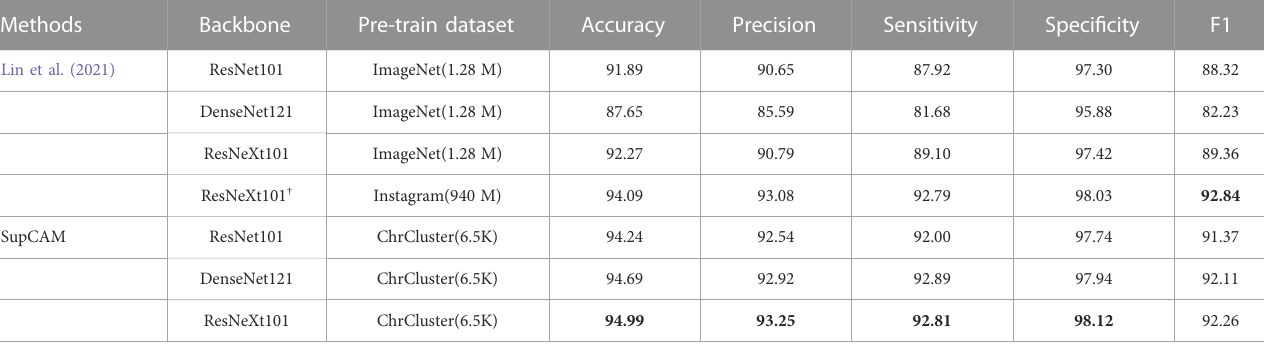
TABLE 1 Comparison with previous methods. All experiments were conducted following the division principle in Lin et al. (2021). ResNeXt101: ResNeXt101 32 × 8d; † : ResNeXt101-32 × 8d attached with a customized header network invented by Lin et al. (2021); ImageNet: 1.28 million images with 1,000-class ImageNet dataset;